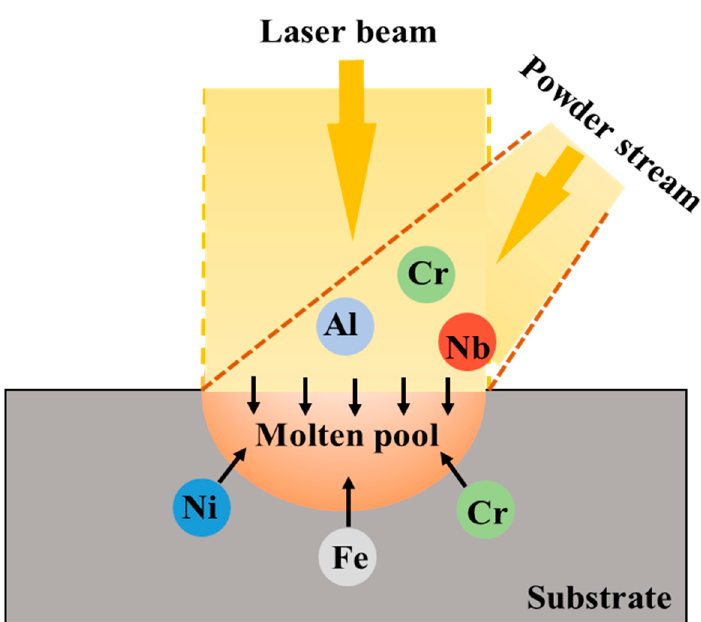
Figure 1. Laser surface alloying process.